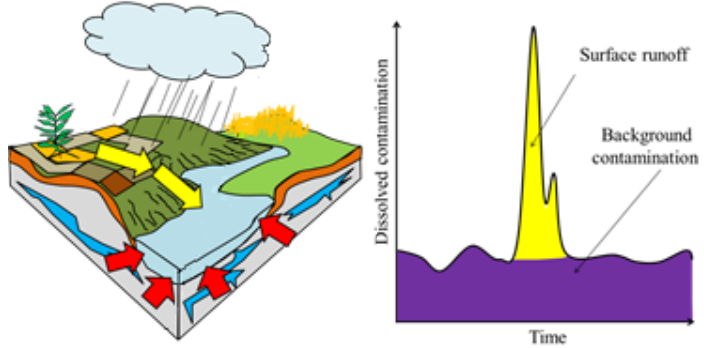
Figure 10. Abstract of the principal findings of this study; the sketch on the left side pictures the sources mixture of dissolved pesticides in the Canche River surface water, runoff originating from agricultural fields during rain events (yellow arrows) and input of groundwater (red arrows). The right panel shows a schematic view on contaminant concentrations in the river, highlighting the temporal character of the two main input sources, relatively constant for the groundwater “background contamination” and important punctual peaks for surface runoff contamination.